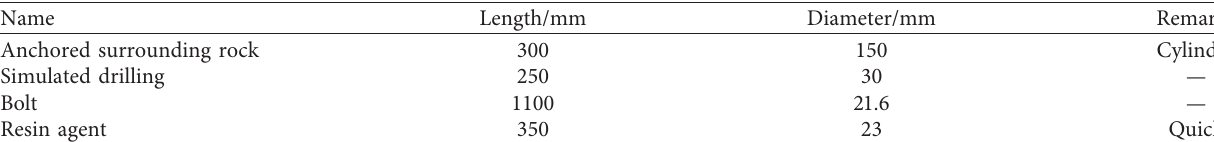
Figure 3: Specimen preparation of anchorage surrounding rock. Table 1: Simulation materials and